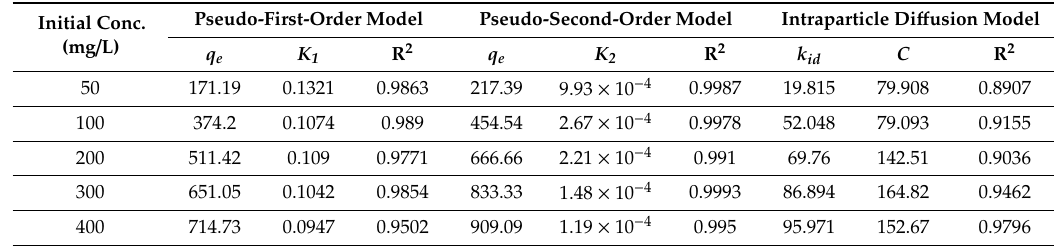
Table 1. The kinetic parameters and coe ffi cients of the pseudo-first-order, pseudo-second-order, and intraparticle models for RhB adsorption on MIL-100(Fe) @Fe 3 O 4 @AC. Initial Conc. (mg /